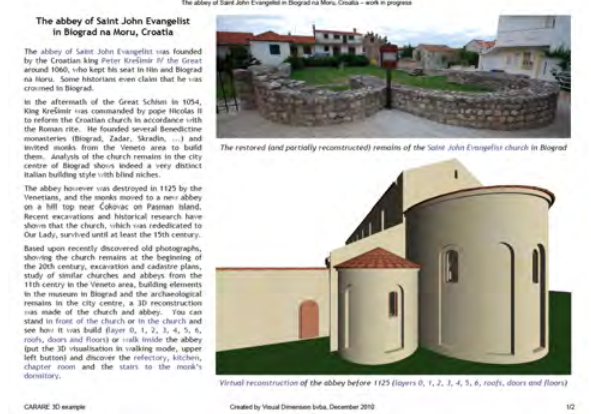
Figure 4. Screenshot of 3D PDF